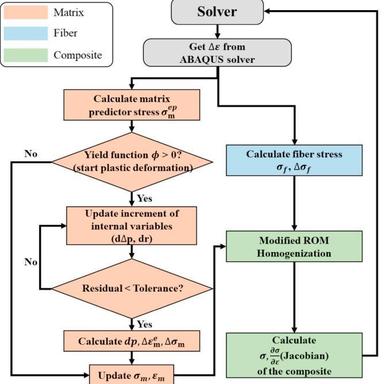
Overall flow of the analysis algorithm in UMAT for NP Cf/SiCm.